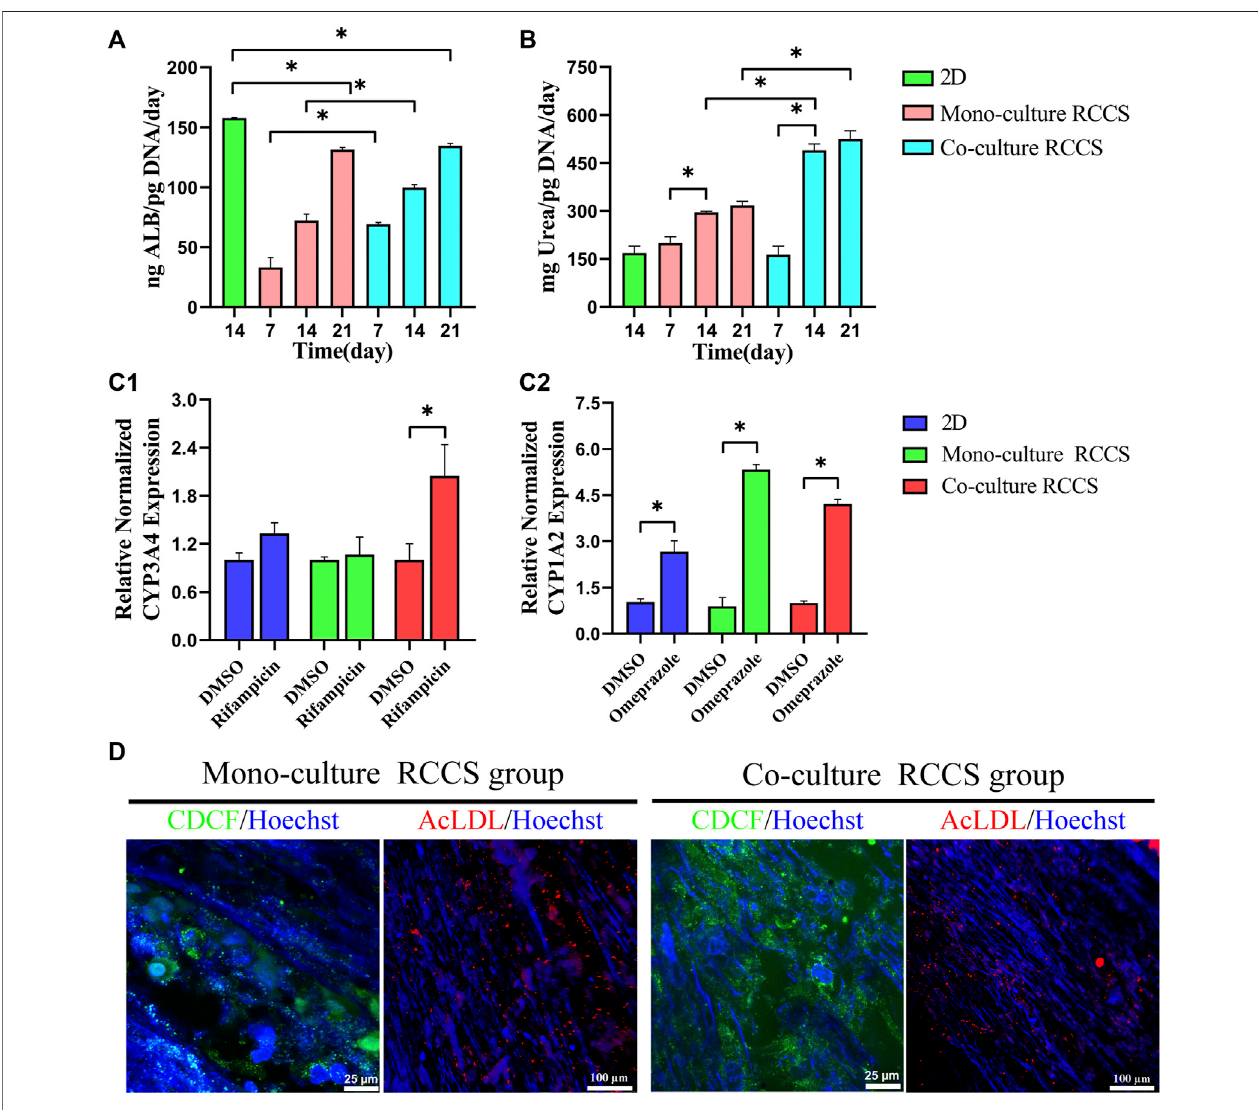
FIGURE 8 | Functional evaluation of iHepLPC-Heps on composite SFC scaffolds. Albumin secretion of different hepatic cultures was assayed using ELISA (A) . Urea synthesis of iHepLPC-Heps cultured under different conditions (B) . Induction of CYP3A4 (C1) and CYP1A2 (C2) expression in response to stimulation with omeprazole and rifampicin, assayed using RT-qPCR. DiI-LDL uptake and CDCFDA staining (D) of iHepLPC-Heps were examined in both groups. (* p < 0.05).